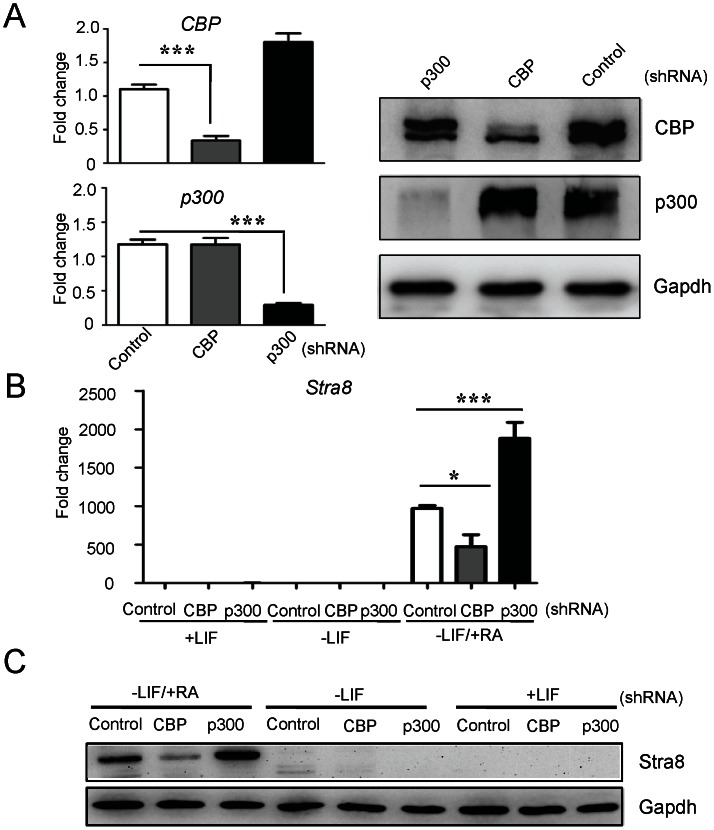
The effects of CBP and p300 knockdown on RA-mediated Stra8 expression in mouse ESCs.(A) Real-time PCR and western blot analysis to measure the mRNA and protein levels of CBP and p300 in control, CBP or p300 shRNA-infected ESCs. The mRNA expression levels were normalized to Gapdh and presented as fold change over control set. Data are means ± SEM (n = 3). P<0.001(***) vs. control shRNA cultures (One-way ANOVA with Turkey-Kramer post hoc test). Gapdh was used as a protein loading control. (B) Real-time PCR to analyze the Stra8 expression in control, CBP or p300 shRNA-infected ESCs after treatment with +LIF, −LIF or −LIF/+RA for 24 h, as indicated. The mRNA expression levels were normalized to Gapdh and presented as fold change over control shRNA (+LIF) set. Data are means ±SEM (n = 3). P<0.05(*) and P<0.001(***) vs. control shRNA cultures under RA treatment (One-way ANOVA with Turkey-Kramer post hoc test). (C) Western blot to analyze the protein levels of Stra8 in control, CBP or p300 shRNA-infected ESCs following treatment with +LIF, −LIF or −LIF/+RA for 24 h. Gapdh was used as a protein loading control.